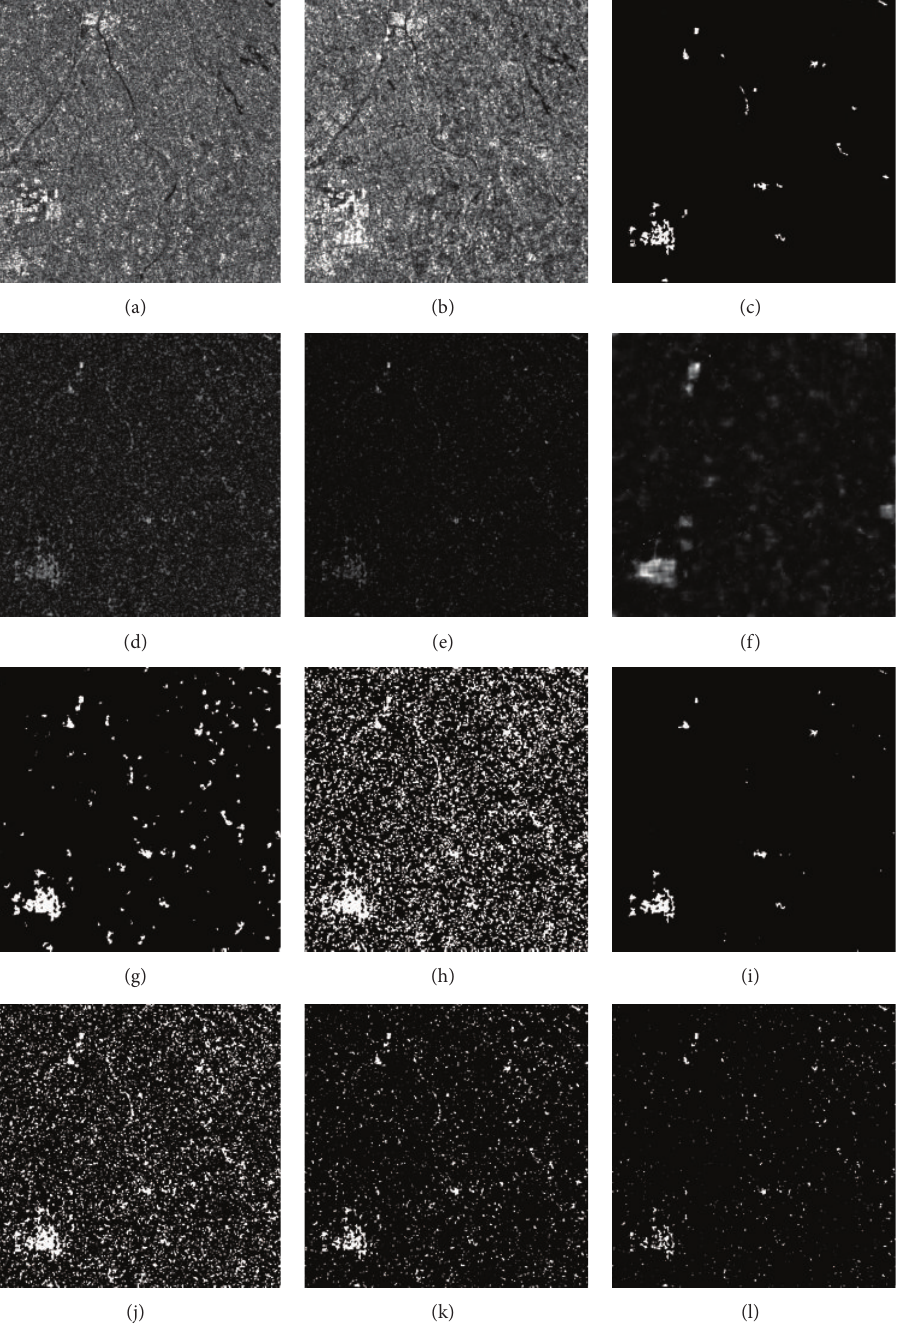
Figure 5: Experimental results on WenChuan Building dataset. (a) Image acquired in March 2008, (b) image acquired in June 2008, (c) ground truth, (d) log ratio DI, (e) Nakagami DI, (f) CKLD DI, (g) change map by CWT-EM, (h) change map by MRF-FCM, (i) change map by MSRM, (j) change map by LR-GKIT, (k) change map by NLR-GKIT, and (l) change map by